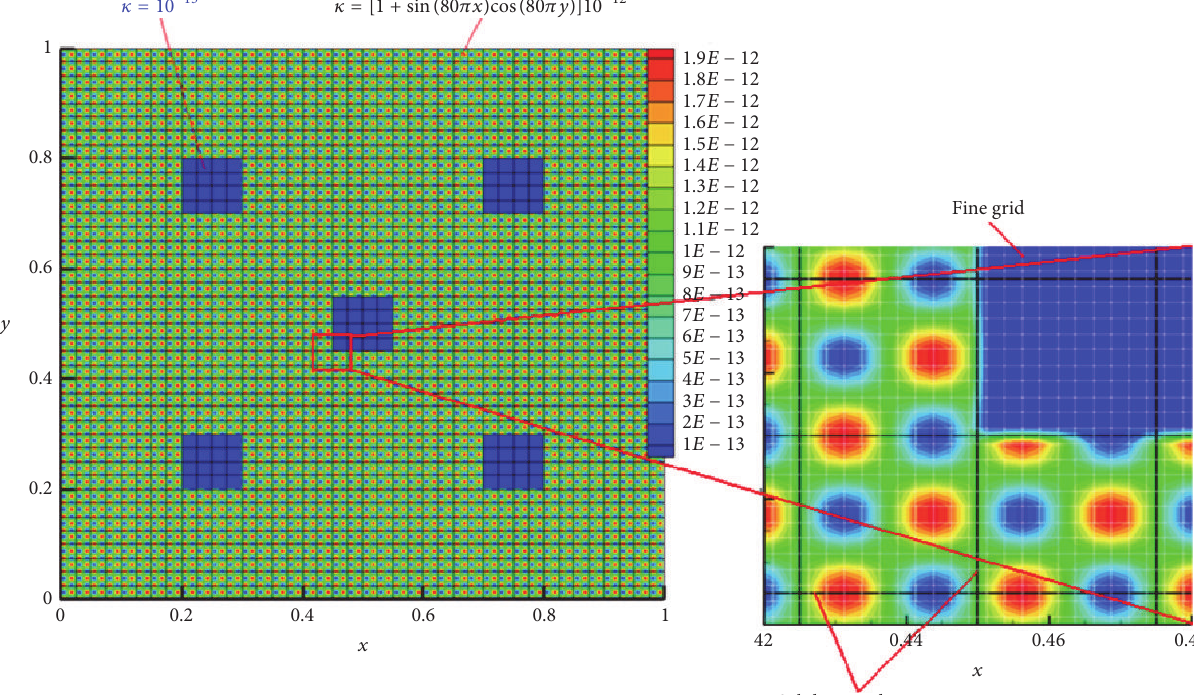
Figure 4: Distribution of the permeability 𝜅( ⃗𝑥) , 𝜅 const = 10 −13